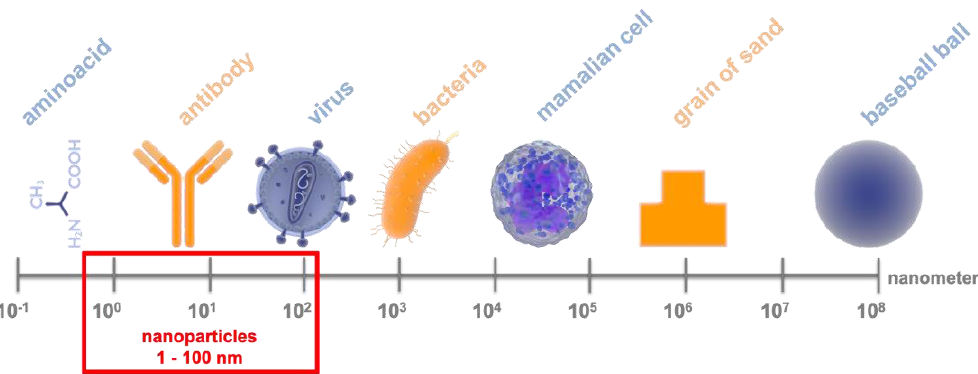
Figure 1. Comparison of nanoparticle size to other objects; presented on a logarithmic scale.